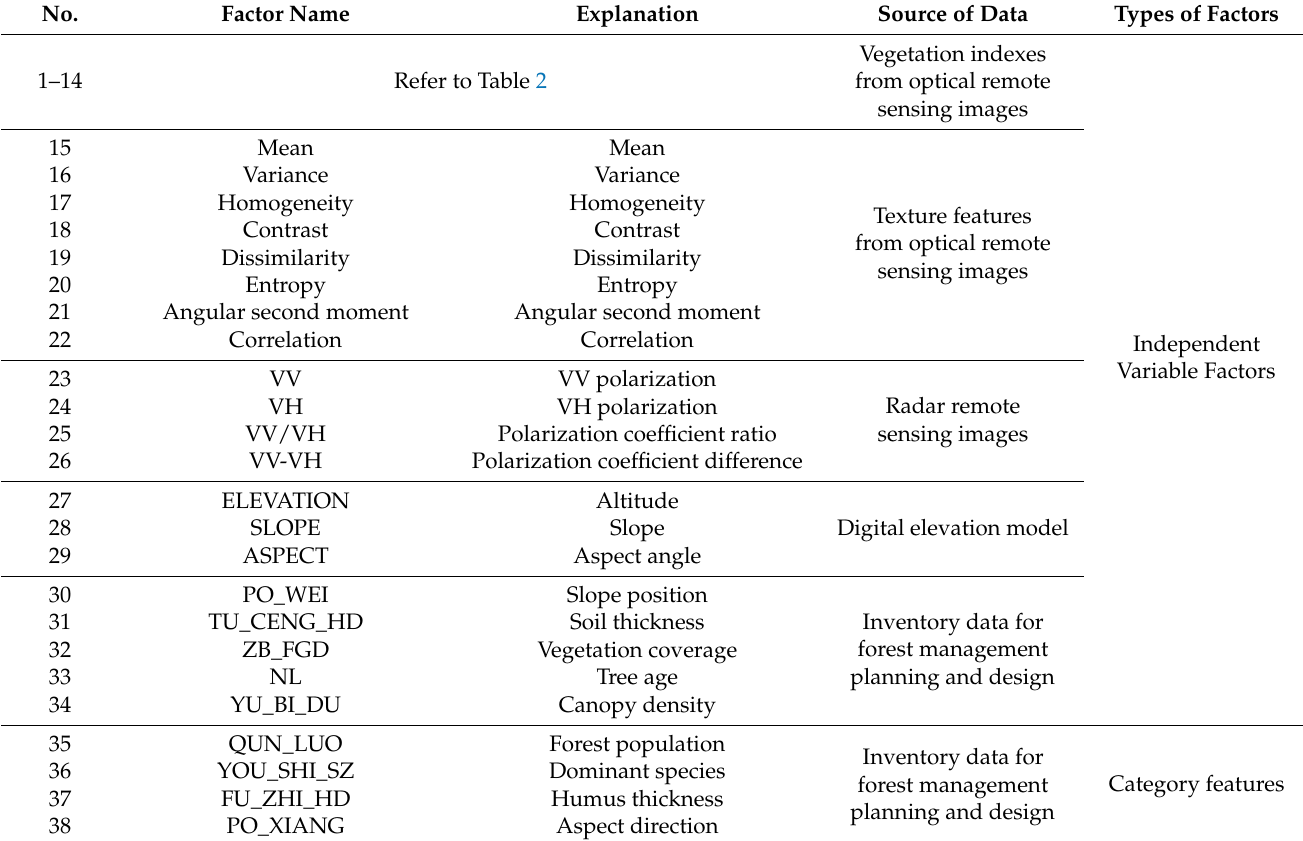
Table 3. List of the characteristic